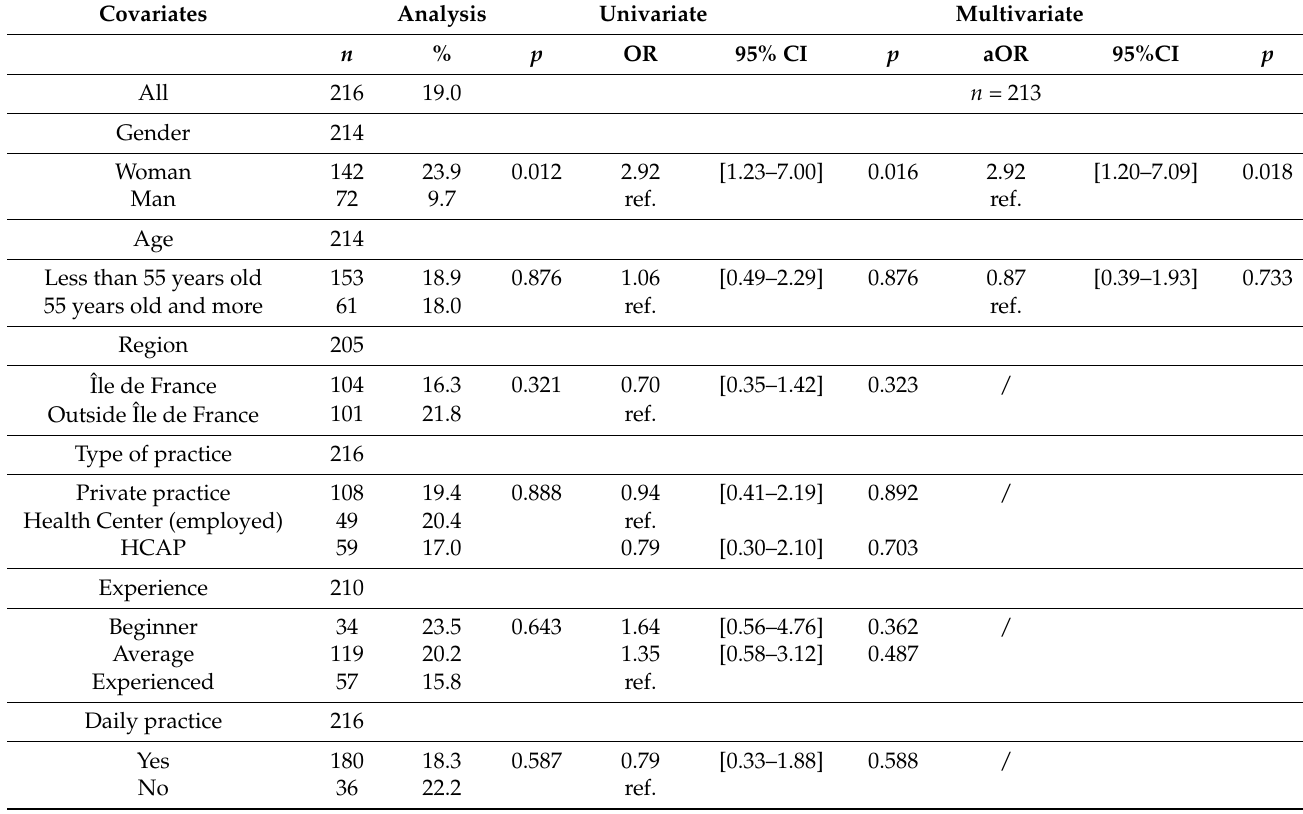
Table 3. Results of logistic regression models estimating the association between the use of specialized websites informing about country-of-origin National Immunization Programs and general practitioner’s profile, among 219 general practitioners interviewed in France